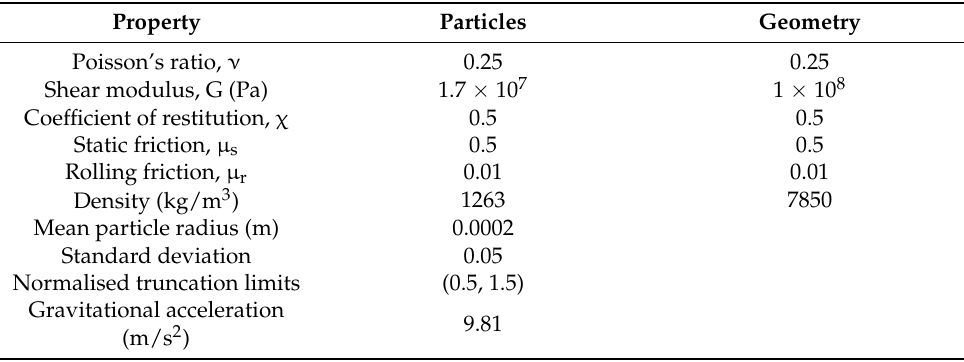
Table 3. Reference values of the DEM input parameters.